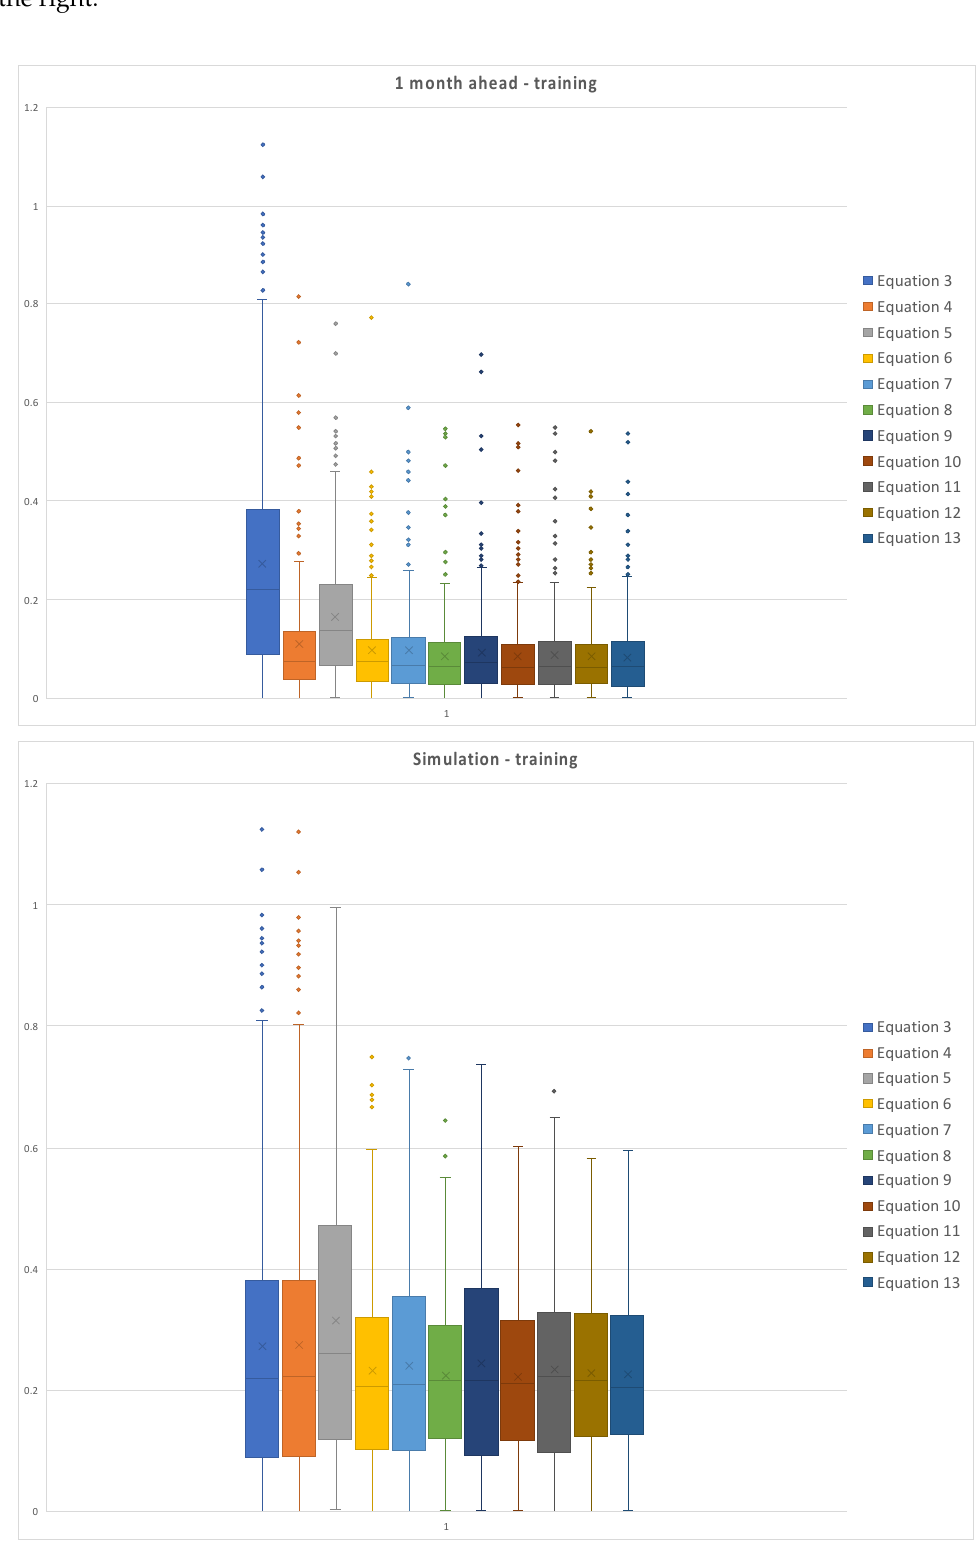
Figure 6. Box plot of the absolute values of errors of the training set for the one month ahead and simulation.